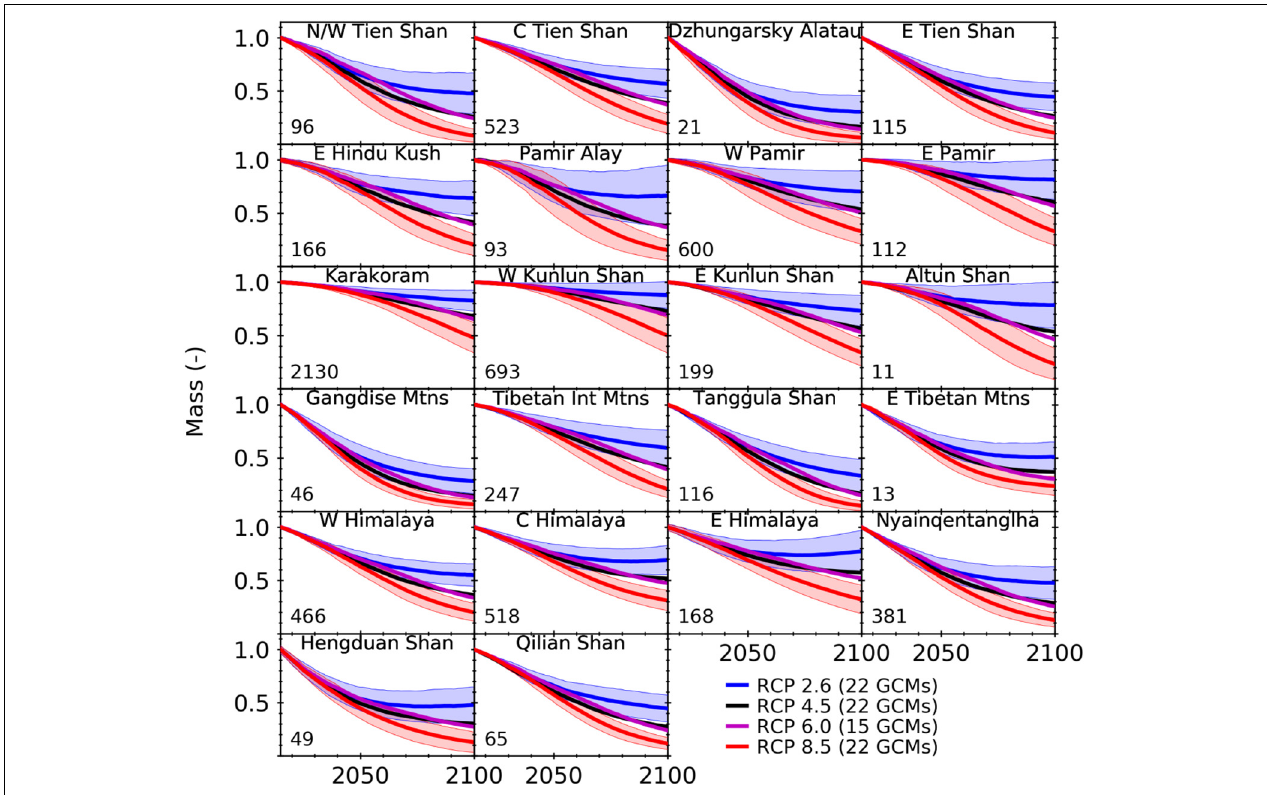
FIGURE 3 | Regional multi-GCM means ( ± 1 standard deviation) of normalized mass remaining, relative to 2015, for up to 22 GCMs and 4 RCP scenarios from 2015 to 2100. Uncertainty only shown for RCP 2.6 and RCP 8.5 for clarity. Numbers in lower left corner of each subplot refer to the region’s initial glacier mass (Gt). Subplots of regions from Bolch et al. (2019) are roughly ordered by geographic location. C, Central; E, Eastern; N, Northern; W, Western; Int, Interior; Mtns,